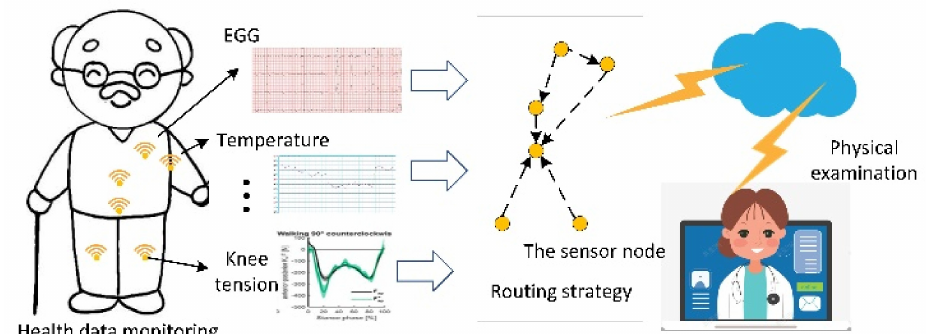
Figure 1. Schematic diagram of the health-monitoring network for the elderly.